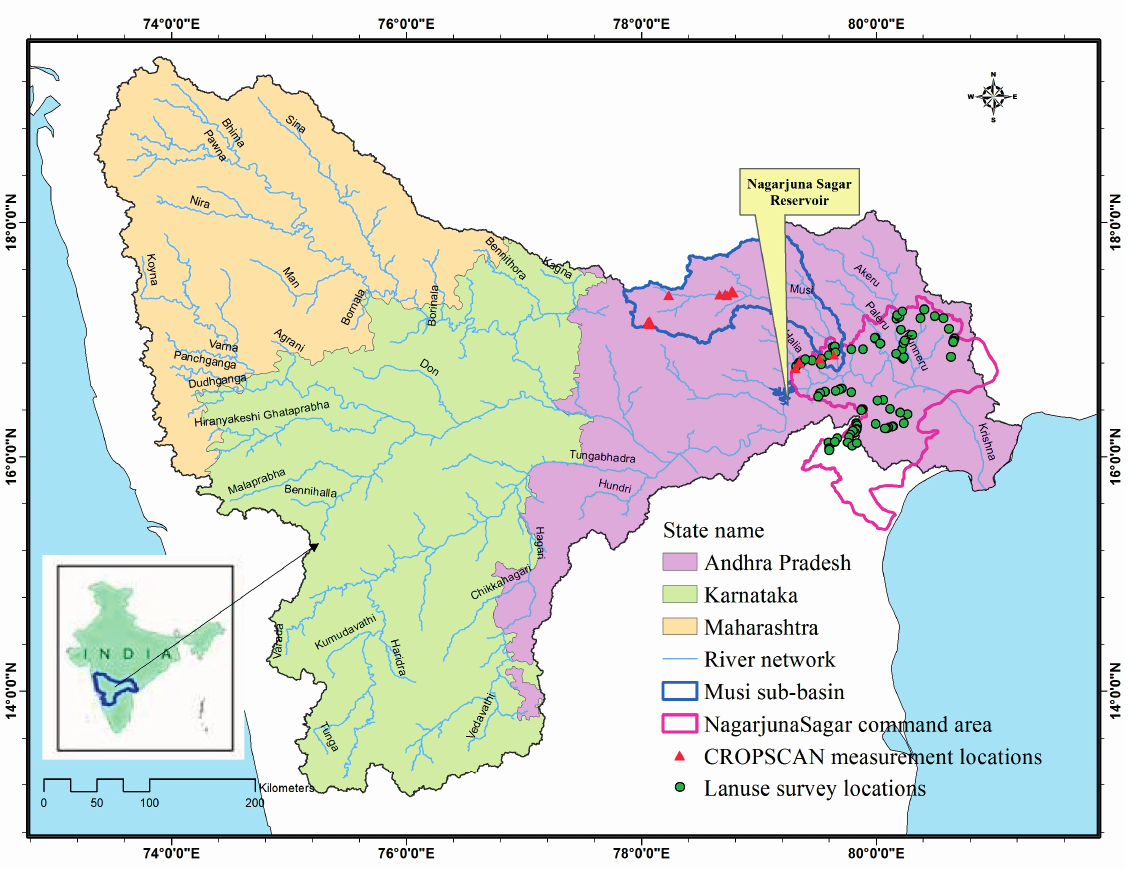
Figure 1. Ground survey locations of paddy rice fields used for rice algorithm where